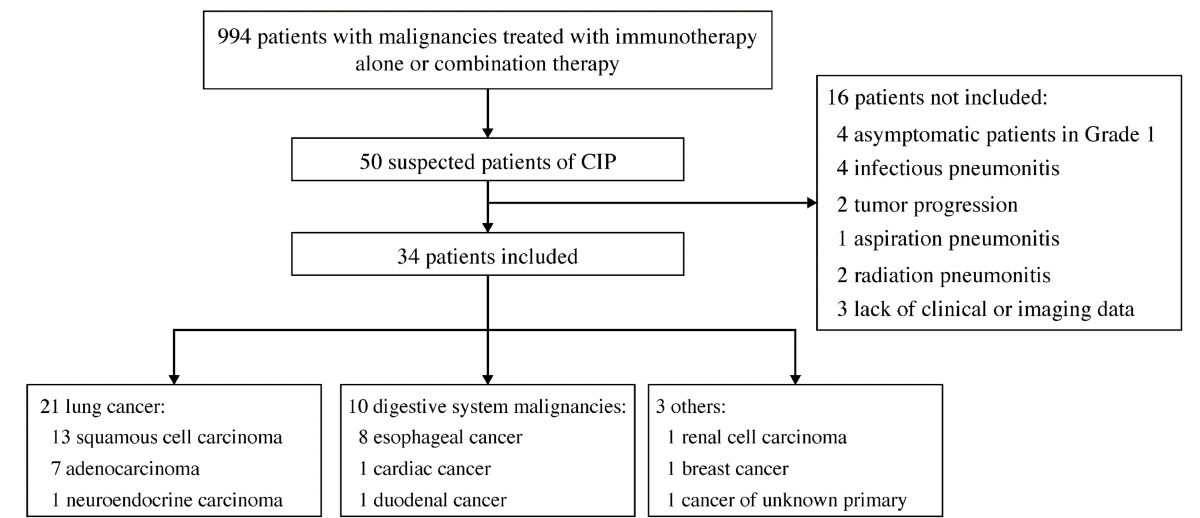
Figure 1. Study flowchart. Abbreviation: CIP, checkpoint inhibitor-related pneumonitis.